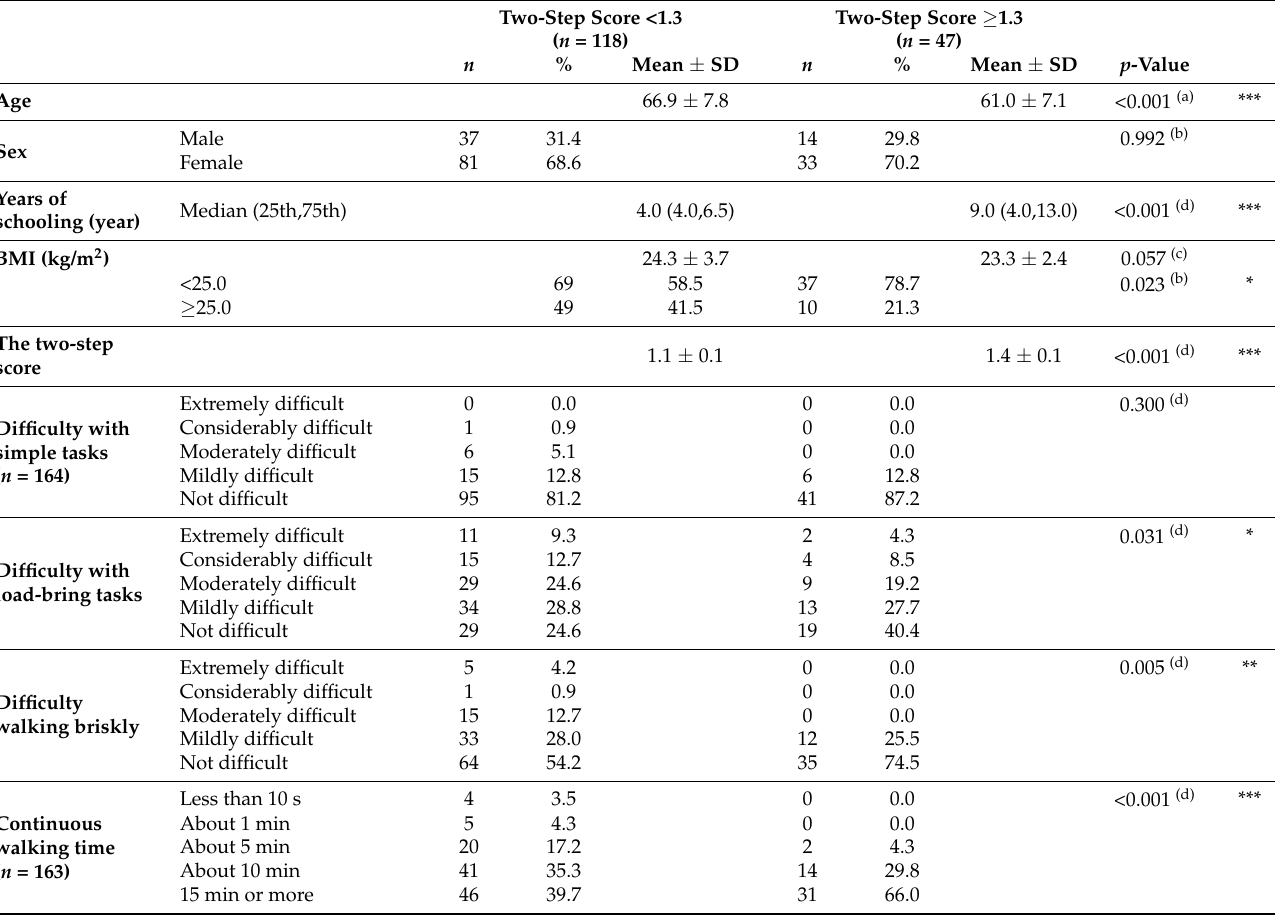
Table 1. Two-step test score and associated factors ( n =